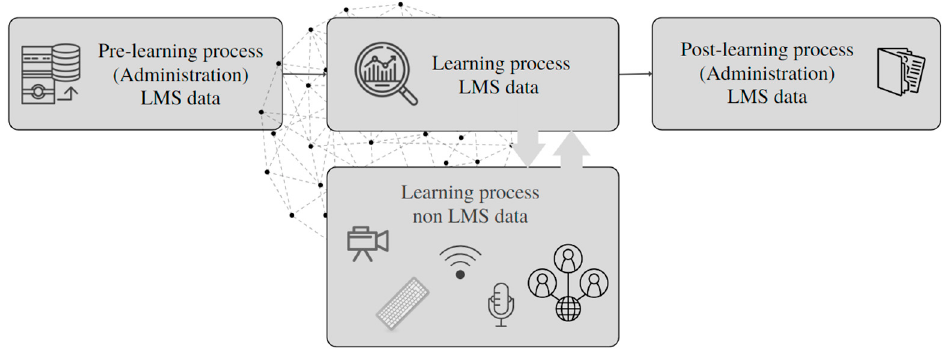
Figure 2. LMS Data and Non-LMS data gathering.